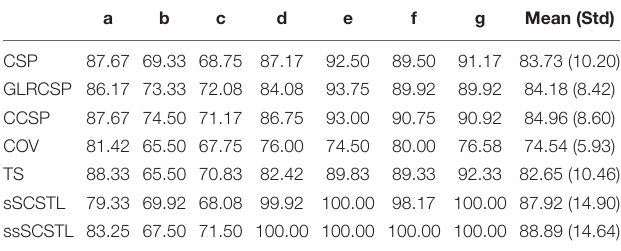
TABLE 5 | Average classification accuracies of supervised and semi-supervised algorithms for all subjects on dataset MI2 ( R l = 40%).